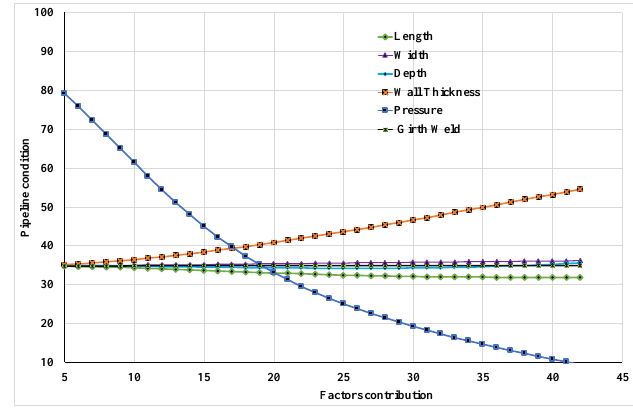
Figure 11. Deterioration profiles of factors.